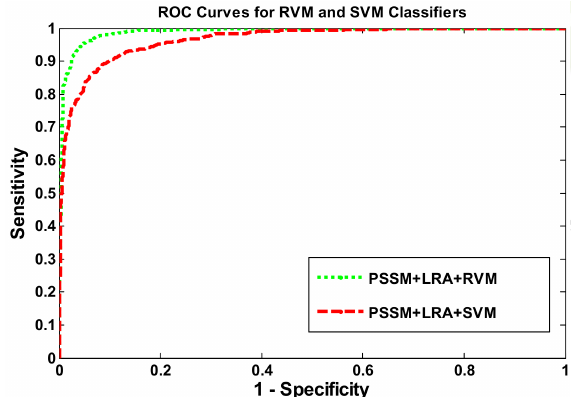
Figure 1. A comparison of the receiver operating characteristic (ROC) curves of the relevance vector machines (RVMs) classifier and the support vector machines (SVMs) classifier on the Yeast